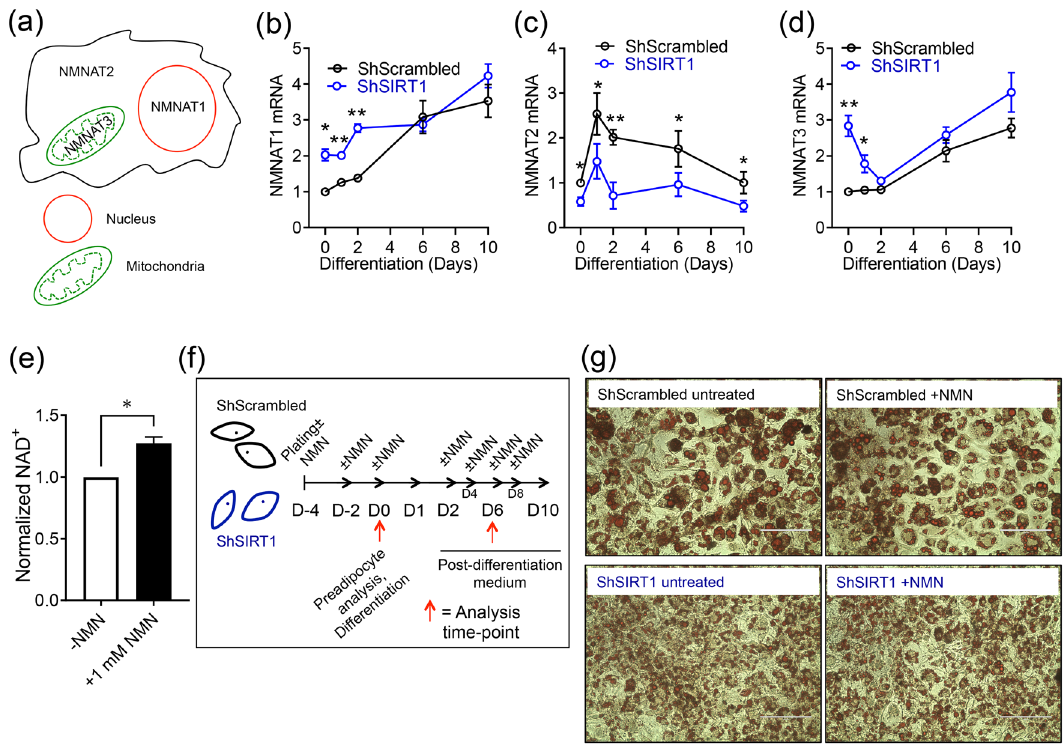
Figure 7. SIRT1 promoted NMNAT2 expression during 3T3-L1 differentiation and constitutively inhibited NMNAT1/3 expression. ( a ) Illustration of the subcellular localization of NMNAT enzymes. ( b–d ) qPCR data comparing the expression of NMNAT1 ( b ), NMNAT2 ( c ) and NMNAT3 ( d ) at specific time-points during adipogenesis in ShScrambled or SIRT1-depleted (ShSIRT1) (pre)adipocytes (n = 4). ( e ) Effect of supplementation with 1 mM NMN on total cellular NAD + levels in 3T3-L1 preadipocytes (n = 4). ( f ) Experimental design to test the effect of NMN supplementation on gene-expression during 3T3-L1 adipogenesis. ( g ) Representative images of Oil Red O (ORO)-stained ShScrambled or SIRT1-depleted (ShSIRT1) adipocytes with (+NMN) or without (−NMN) supplementation with 1 mM NMN. Scale bar, 100 μm. Images were collected at Day 6 post-differentiation and are representative of 3 independent experiments. For statistical analysis of data shown in ( b–d ), pair-wise comparisons were made between ShScrambled and ShSIRT1 groups for each individual time-point using the Student’s t test (n = 4). A Student’s t test was used to perform statistical analysis on the dataset shown in ( e ) (n = 4) (*P < 0.05; **P < were maximal by Day1–2 post-differentiation and returned to basal levels by Day 10. However, SIRT1-depletion led to a sustained increase in CEBPβ levels and expression was significantly higher than ShScrambled throughout